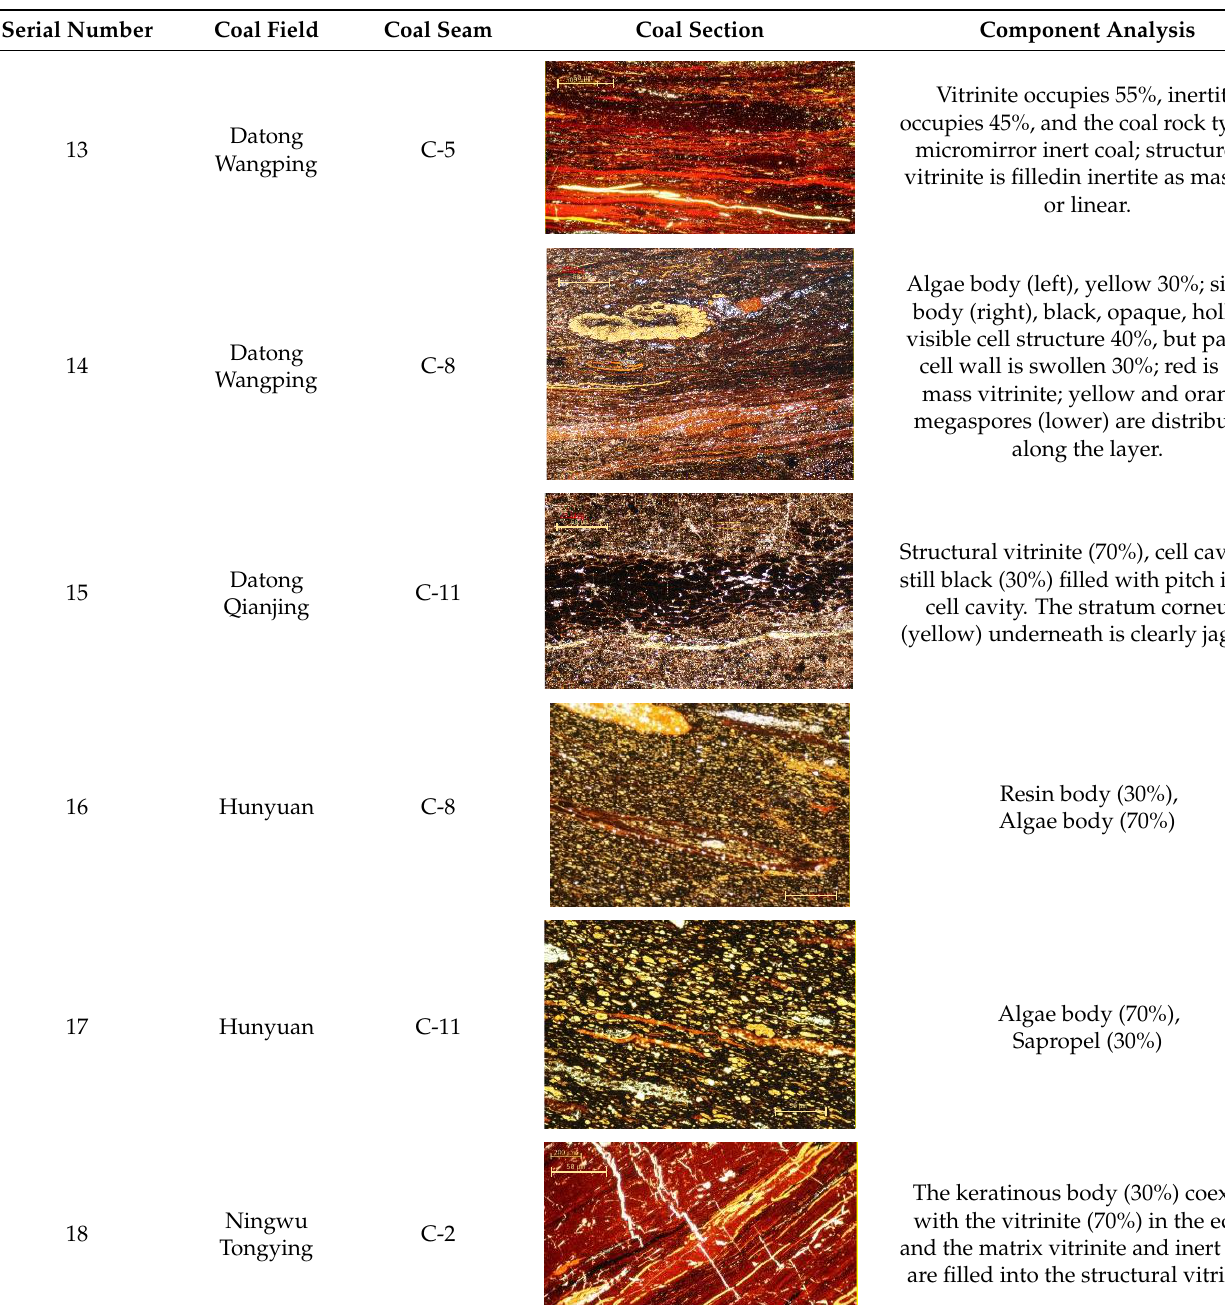
around vitrinites (70%).